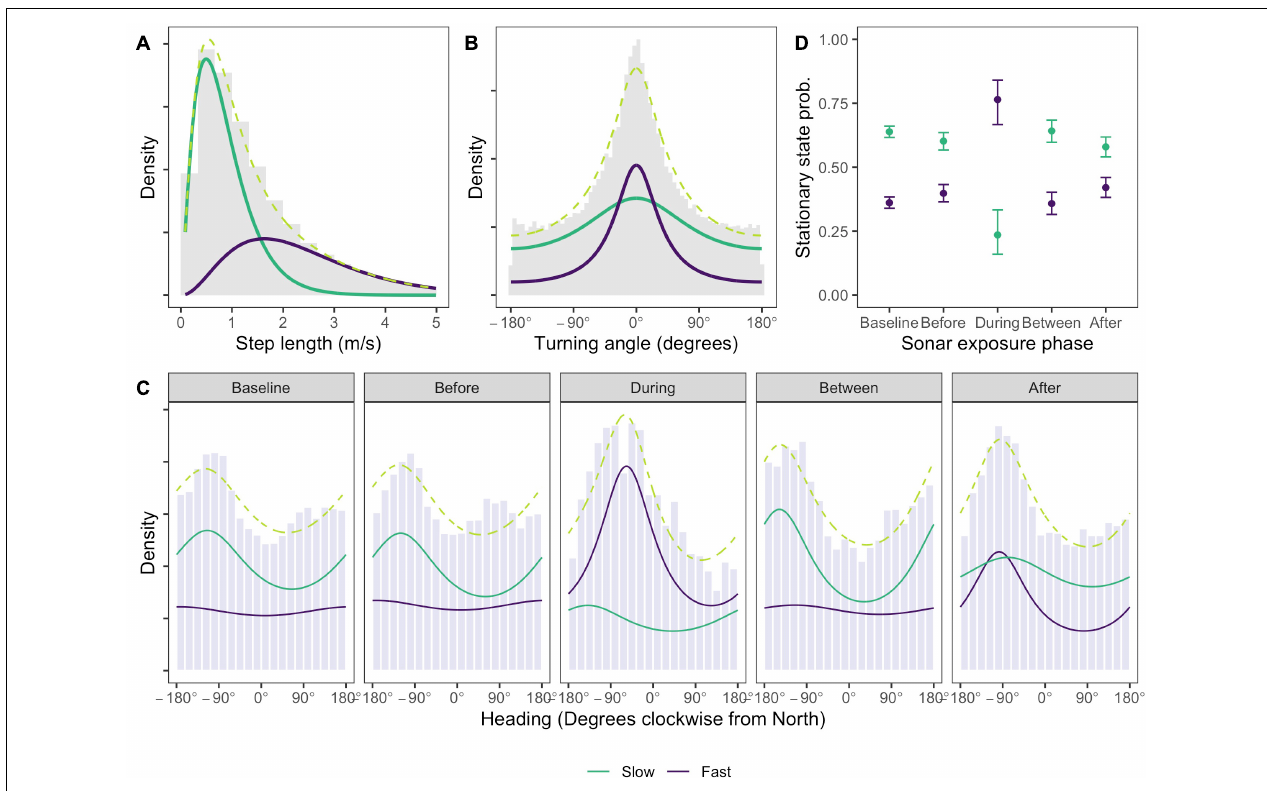
FIGURE 3 | Estimated state-dependent densities for (A) speed, (B) turning angle, (C) whale heading relative to North, and (D) the effect of sonar exposure phase on the probability that a location is found in a given state. Density values are uninformative and so suppressed. One state (green line) comprises slow, undirected movement, most commonly with a heading between south-east and north-west. A second state (purple line) involves faster, more directed travel which, during sonar exposure, is also characterized by more northerly headings that would typically take the whale away from the range of ship activity. Whales are much more likely to be observed in the second state during sonar exposure. Observed data is shown as gray histograms; the marginal distribution (dashed lime green line) shows the sum of the state-dependent densities. Heading densities in panel (C) are standardized within each sonar exposure phase to facilitate comparison between the phases, which have very different sample sizes (see Table 1